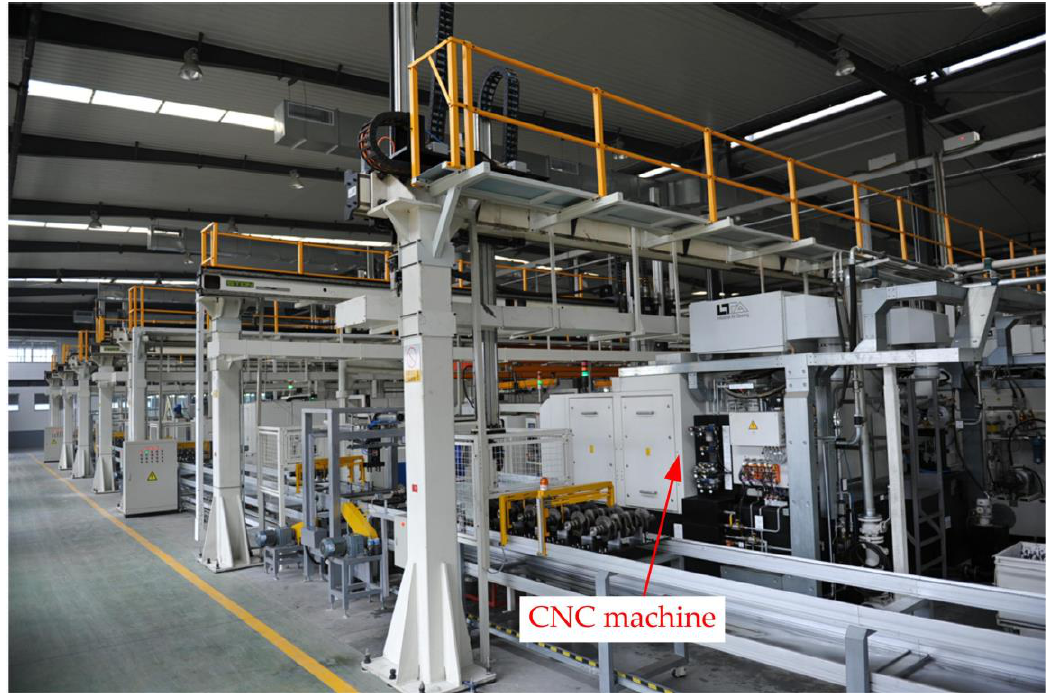
Figure 3. The scene of the automotive part production